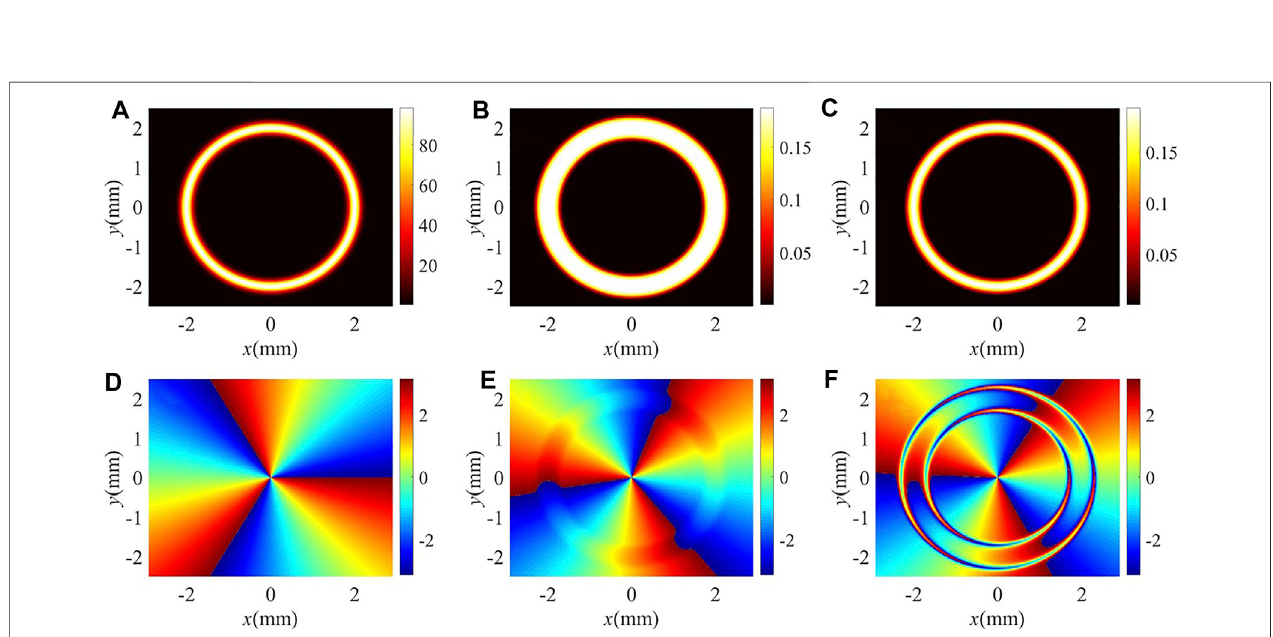
FIGURE 2 | (A,D) Intensity and phase pro fi les of the drive fi eld with POV. (B,C) Intensity and (E,F) phase pro fi les of the FWM fi eld for different values of α , β , and δ : (B,E) α = β =0, δ =0 meV; (C,F) α = − 0.11, β =0.98, δ =5.1 meV.Theotherparametersare ζ p = ζ m =9.2×10 – 3 meV/ μ m, L =100 μ m, l =3, w g =200 μ m, λ =10.83 μ m, R = 2 mm, f = 11.69 mm, Ω p = 1 meV, Ω c = 14 meV, Ω d 0 = 10 meV, Δ p = 16 meV, and Δ c = Δ m = 0 meV.